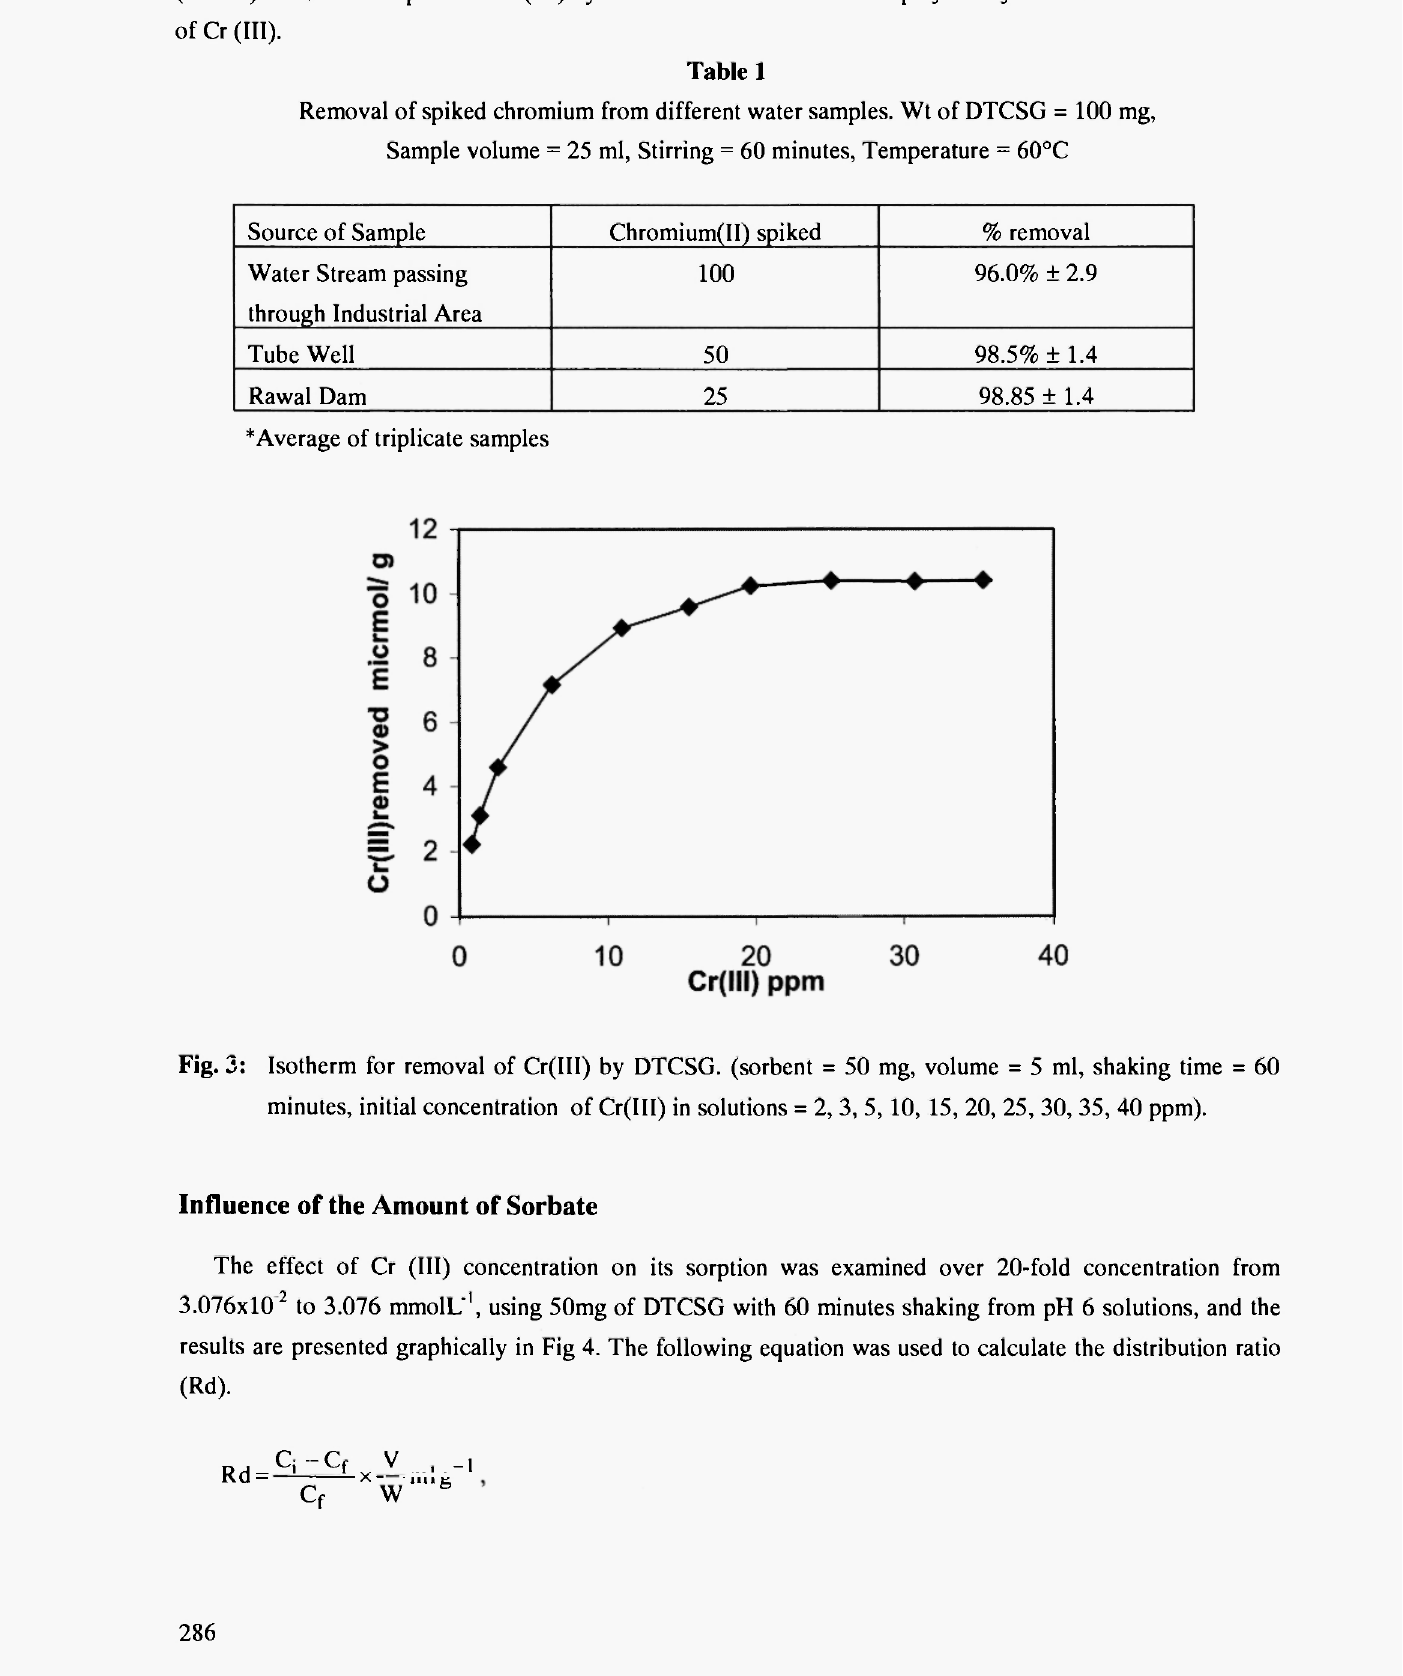
Removal of spiked chromium from different water samples. Wt of DTCSG = 100 mg,